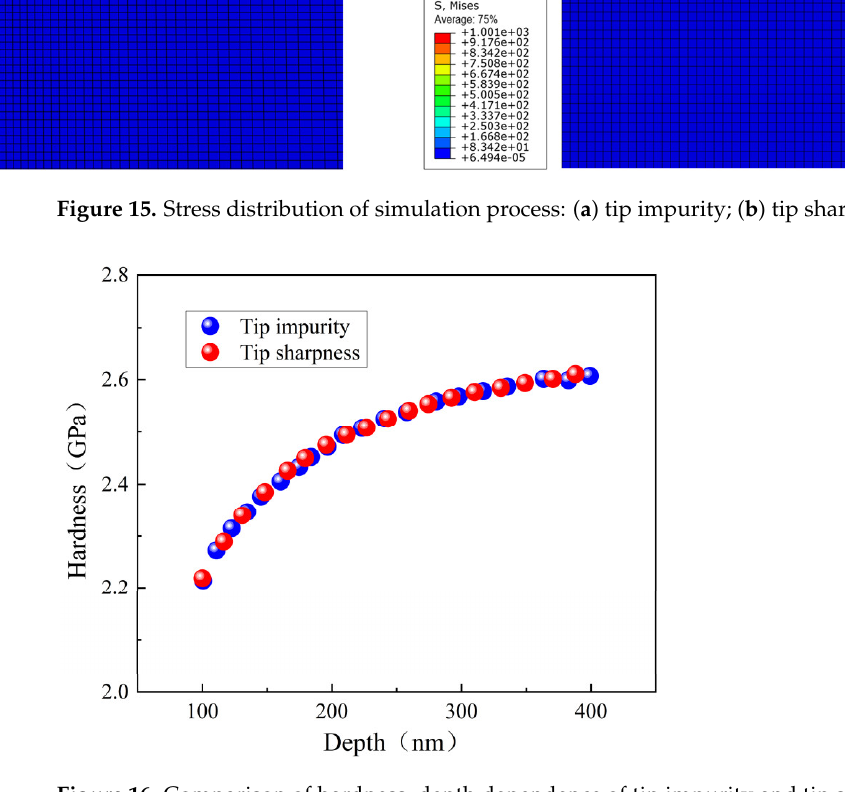
Figure 16. Comparison of hardness–depth dependence of tip impurity and tip sharpness.